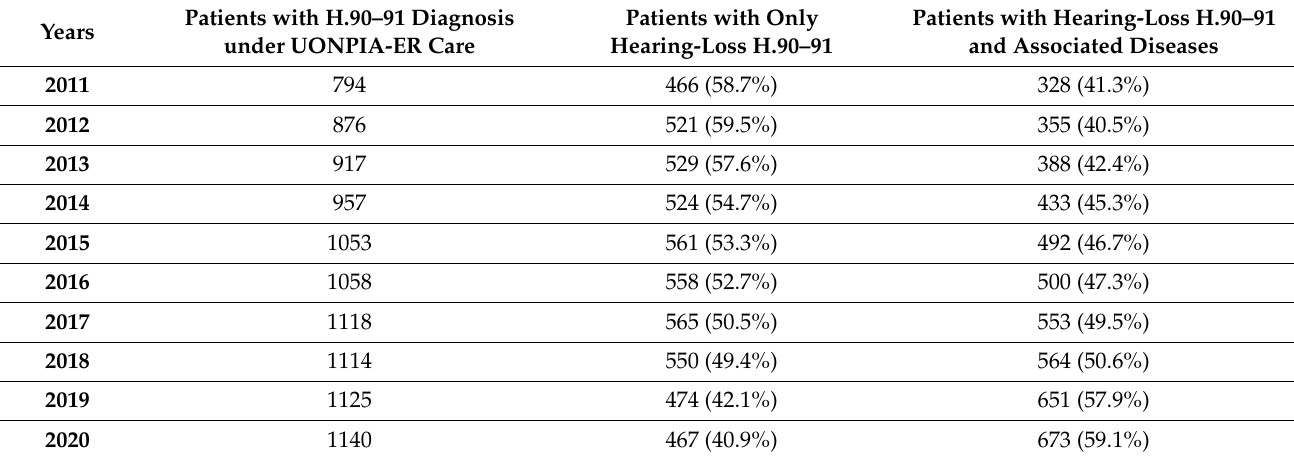
Table 4. Children admitted to CAMHS with a hearing loss code (H90–H91) and with other associated codes.